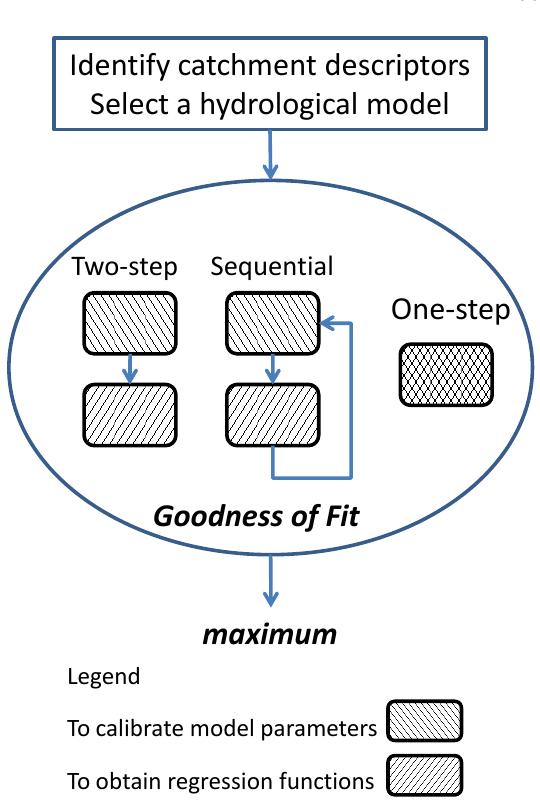
Fig. 3. General procedures of the three regression-based regionali- sation